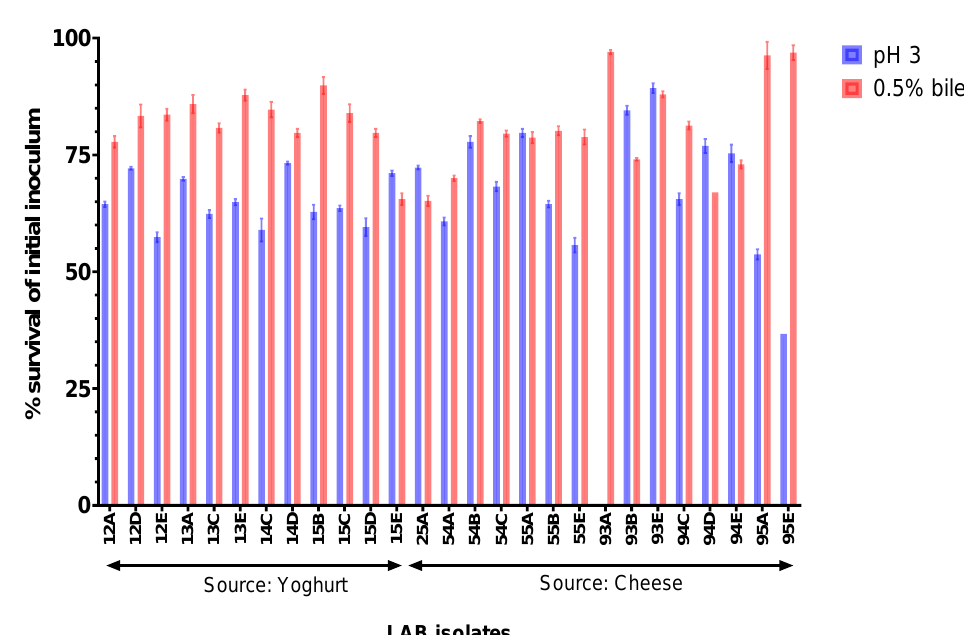
Figure 2. Percentage of survival (from initial inoculum) of the selected LAB isolates after exposure to acidic pH and bile salt solution. Isolates were exposed to pH 3.0 for 3 h at 37 °C and 0.5% ( w / v ) bile salt solution (pH 8.0) for 4 h at 37 °C under stirring (150 rpm). Data are expressed as mean ± SD per condition ( n = 3 ).